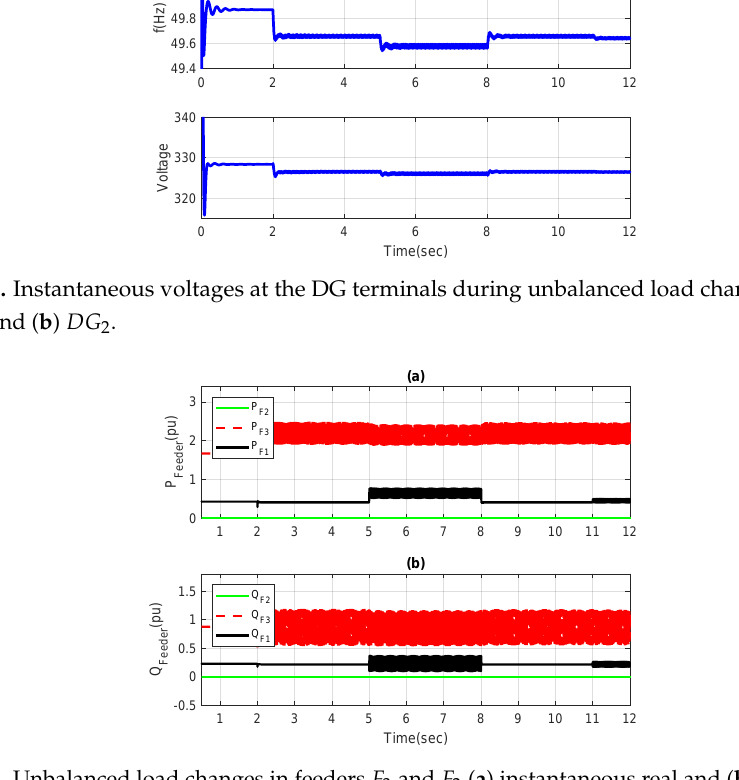
Figure 15. Unbalanced load changes in feeders F 3 and F 2 ( a ) instantaneous real and ( b ) reactive power of feeders.